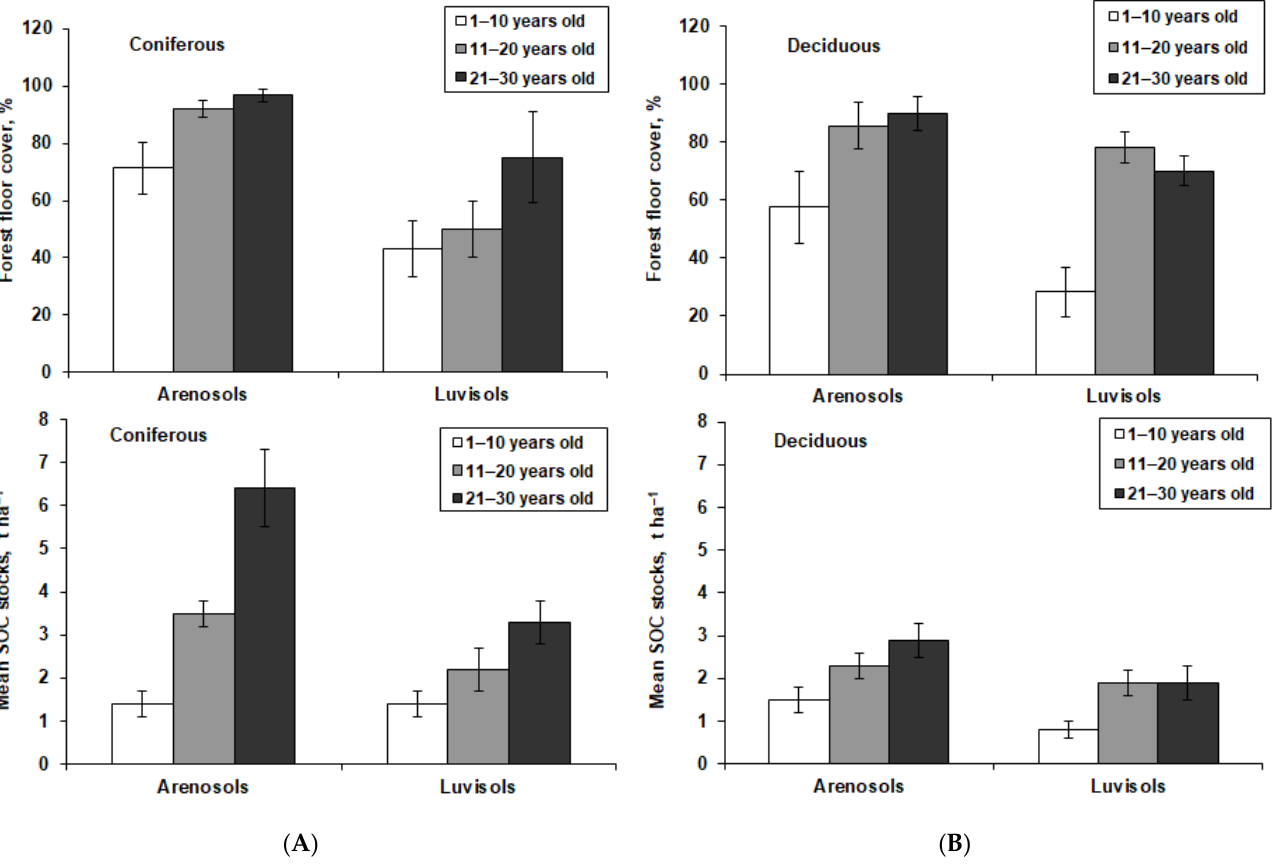
Figure 3. Mean forest floor cover (%) and mean soil organic carbon (SOC) stocks (t ha − 1 ) in the forest floor of afforested